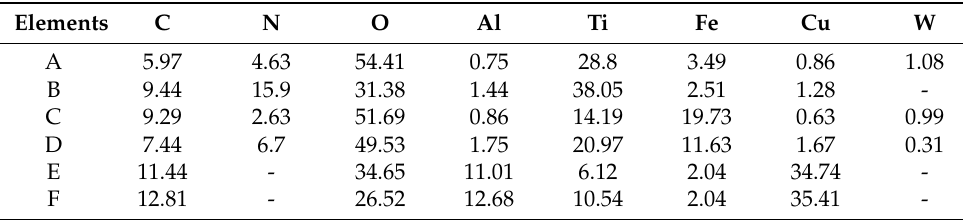
Table 5. Semi-quantitative EDS results for areas A–E in Figure 7 (at.%).